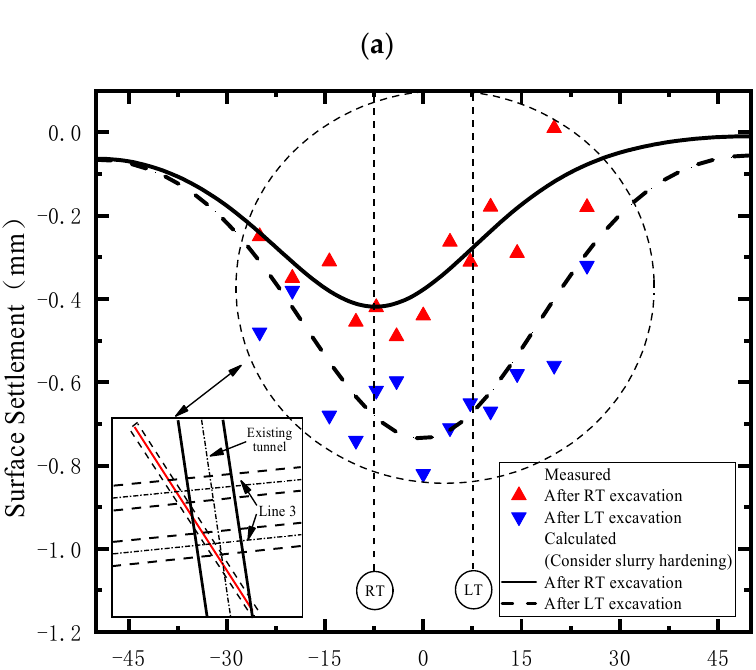
Figure 7. Comparison of calculated and measured values of surface settlement after RT (right line tunnel) and LT (left line tunnel) excavation: ( a ) no consideration of slurry hardening; ( b ) consideration of slurry hardening.